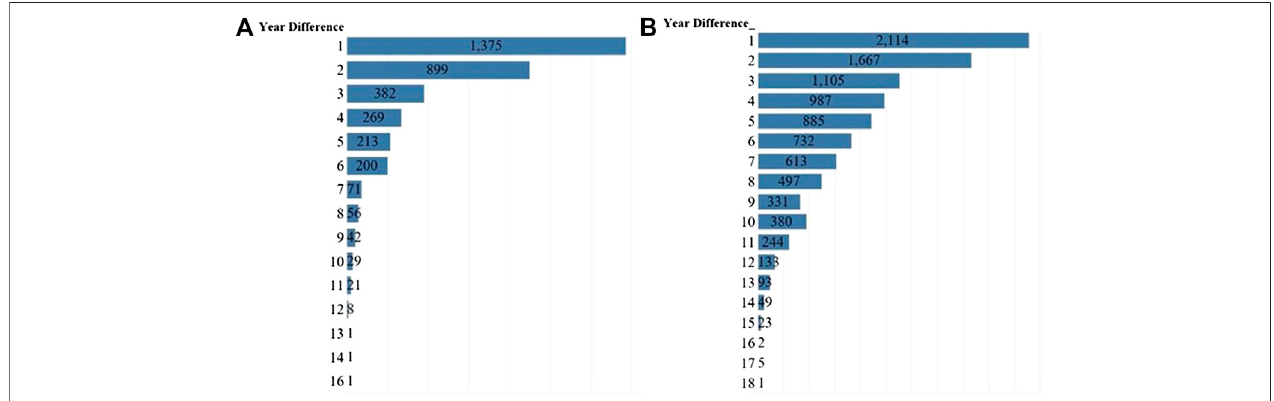
FIGURE5| Thetemporalstructureofcollaborationamongauthorsandinstitutions (A) yearsuntilthesecondco-authoredpublication (B) yearsuntilthesecondco- institutionalco-authoredpublication.Inourdata,mostrepeatcollaborationoccurredafterayear.Medianrepeatcollaborationforauthorswas2yearsandforinstitutions was 4